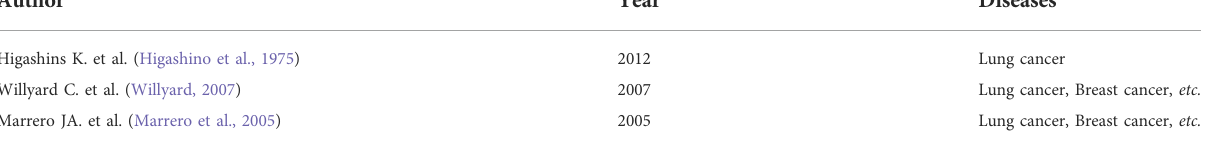
TABLE 6 Studies on the liver cancer from different